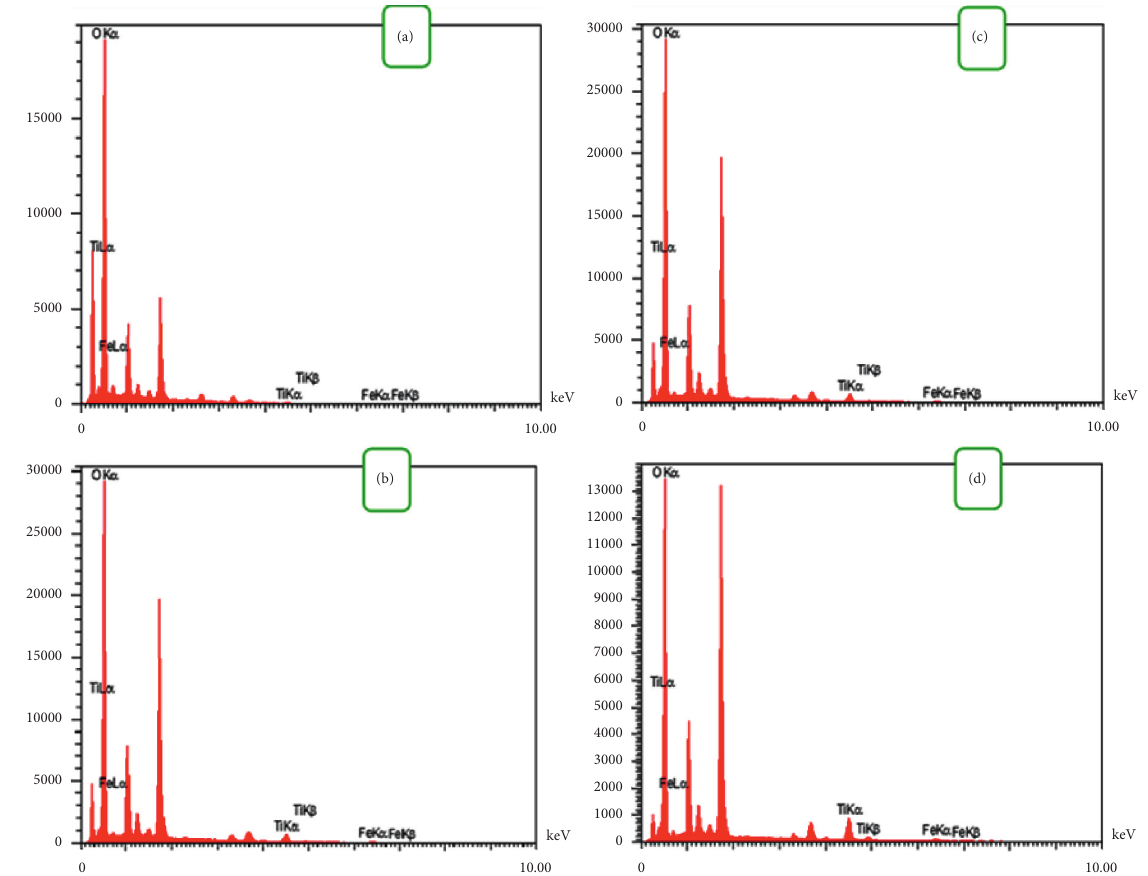
Figure 4: EDX of the NPs prepared: without applying a magnetic field and the LASER fluence: (a) 30mJ/cm 2 and (b) 60mJ/cm 2 ; with applying a magnetic field and the LASER fluence: (c) 30mJ/cm 2 and (d) 60mJ/cm 2